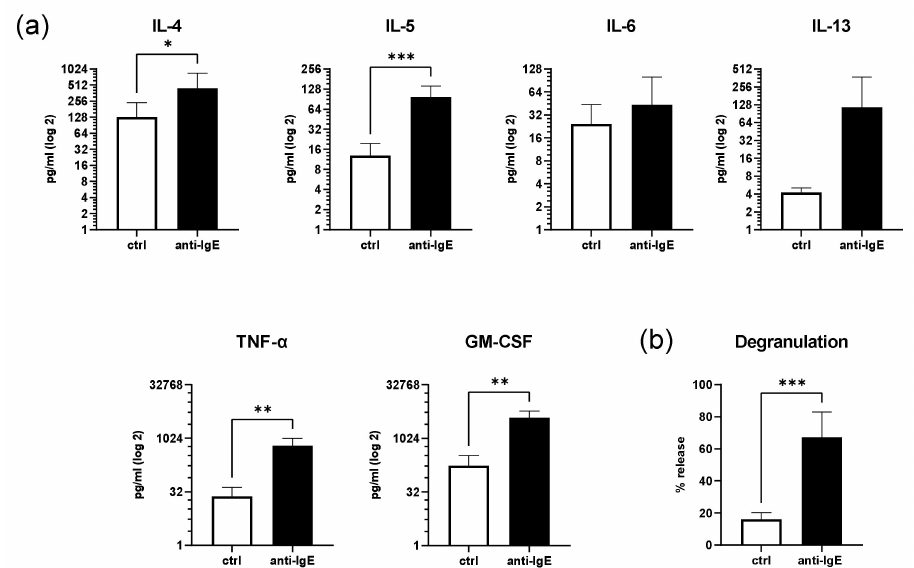
Figure 2. IgE-mediated activation of human skin MCs enhances cytokine and growth factor secretion and degranulation. After IgE-mediated stimulation (anti-IgE), ( a ) the human skin MCs’ cytokine and growth factor secretion ( n = 8), and ( b ) degranulation ( n = 7) were analyzed under glucose- free conditions. ( a , b ) Mean ± SEM, paired Student’s t -test: * p < 0.05, ** p < 0.01, *** p < 0.001). anti-IgE = IgE-pretreated cells cross-linked with anti-IgE; ctrl =